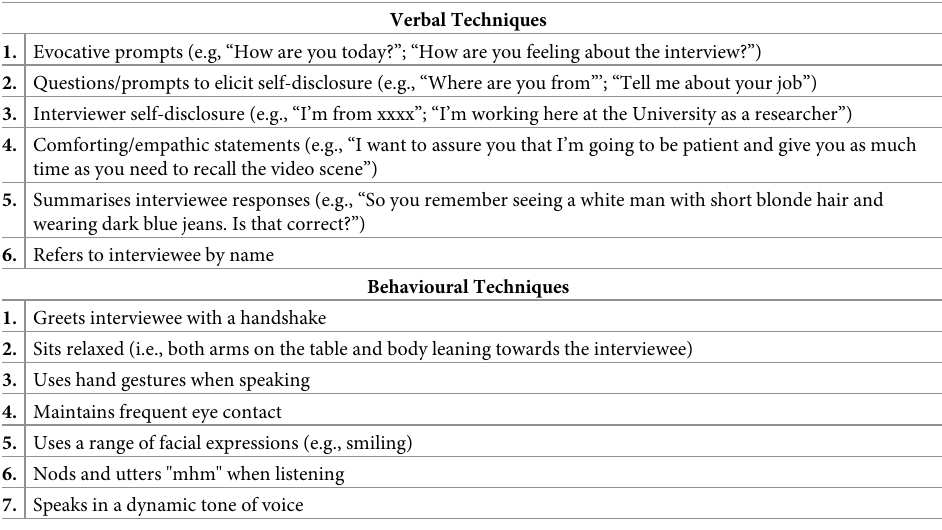
Table 1. Verbal and behavioural rapport-building